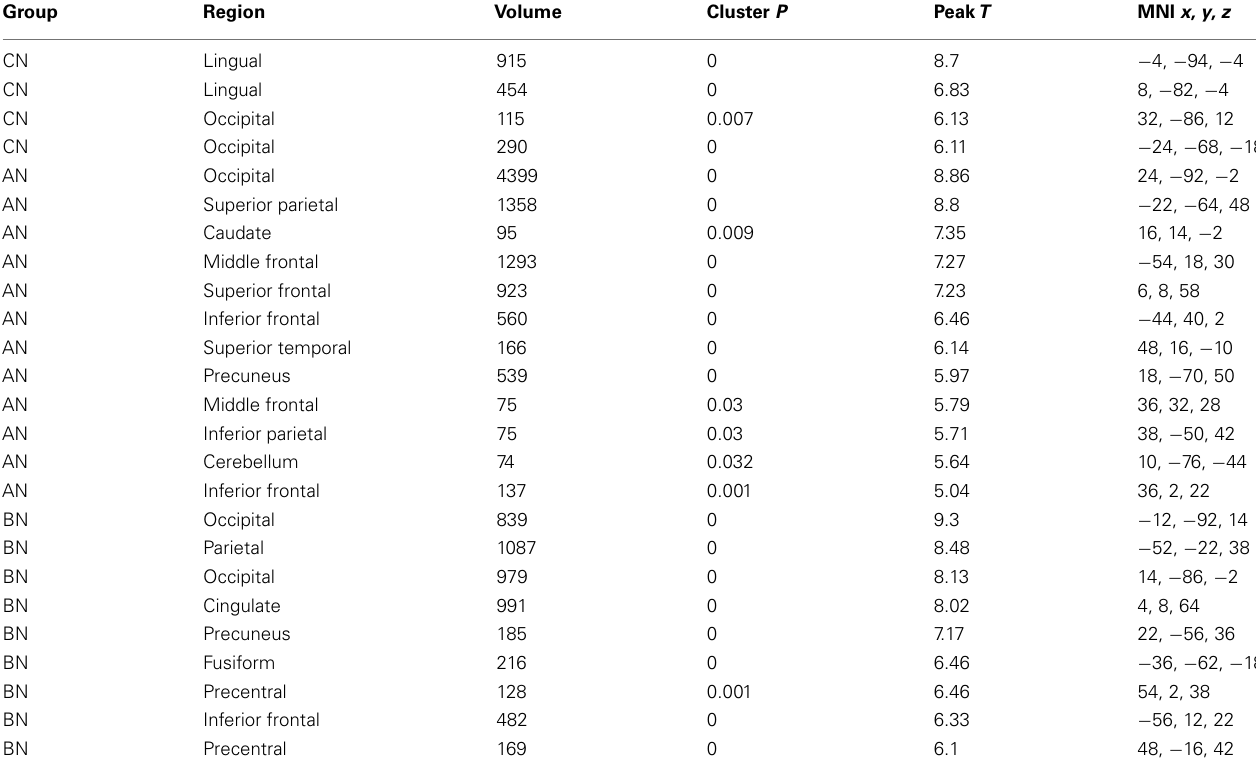
Table 4 | Clusters in the CN,AN, and BN group maps during the Self–Friend contrast of the social identity task. Group